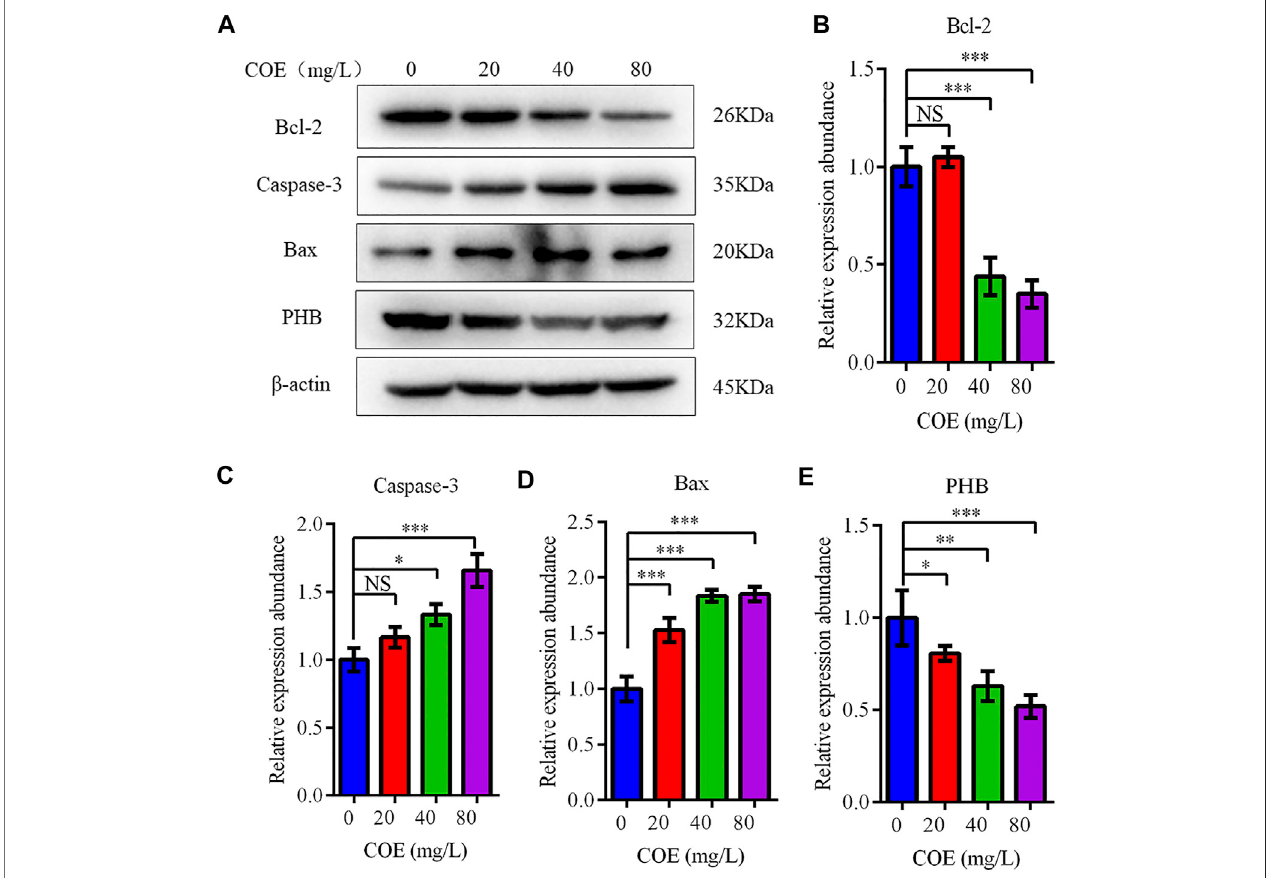
FIGURE 4 | Effect of the ethyl acetate extract of Celastrus orbiculatus (COE) on expression of apoptosis-related proteins in human gastric cancer AGS cells. Bcl-2 expression decreased signi fi cantly, while Bax and Caspase-3 expression increased signi fi cantly after COE treatment (A – E) .